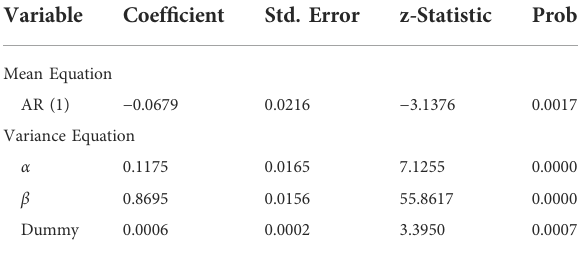
TABLE 11 Parameter estimates of the AR (1) — GARCH (1, 1) model for EUA futures returns in phase III, with structural breaks